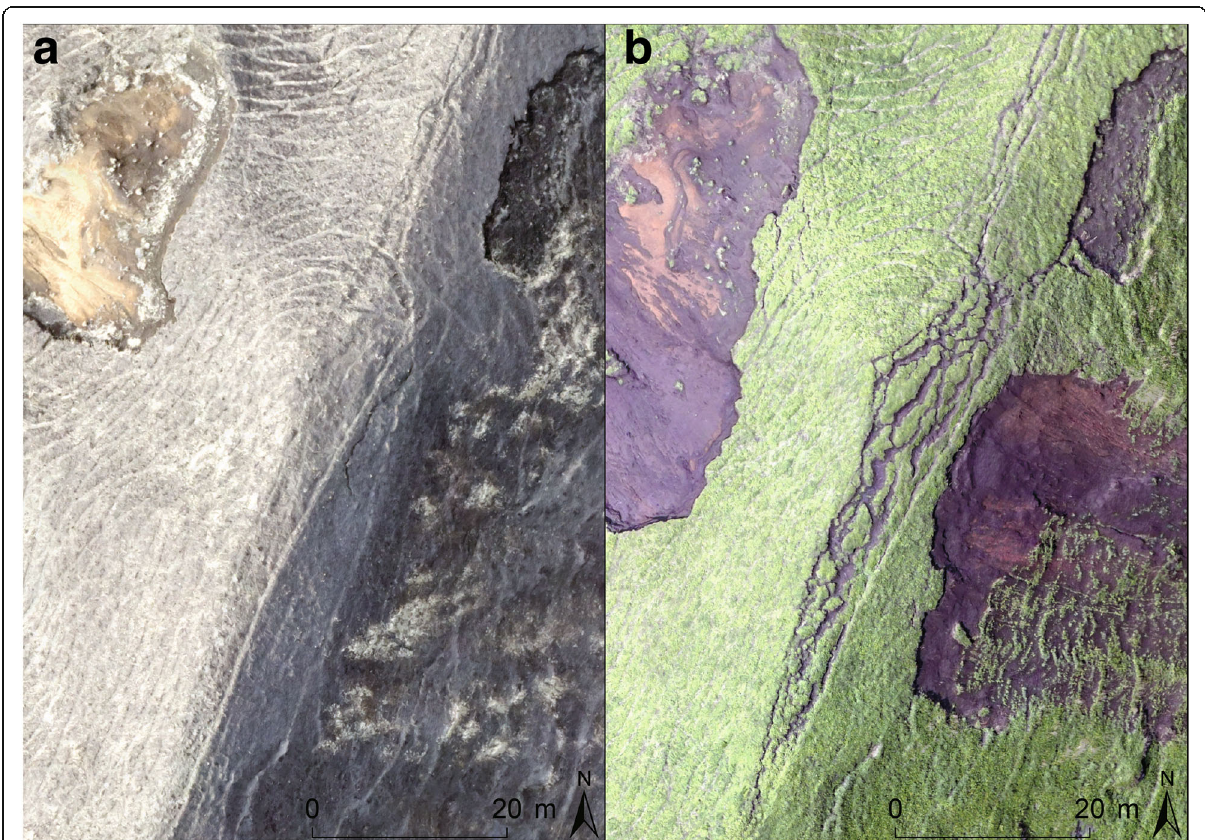
Fig. 5 Example of fissures triggered by the 2016 Kumamoto earthquake shown by orthorectified images acquired in a March and b May